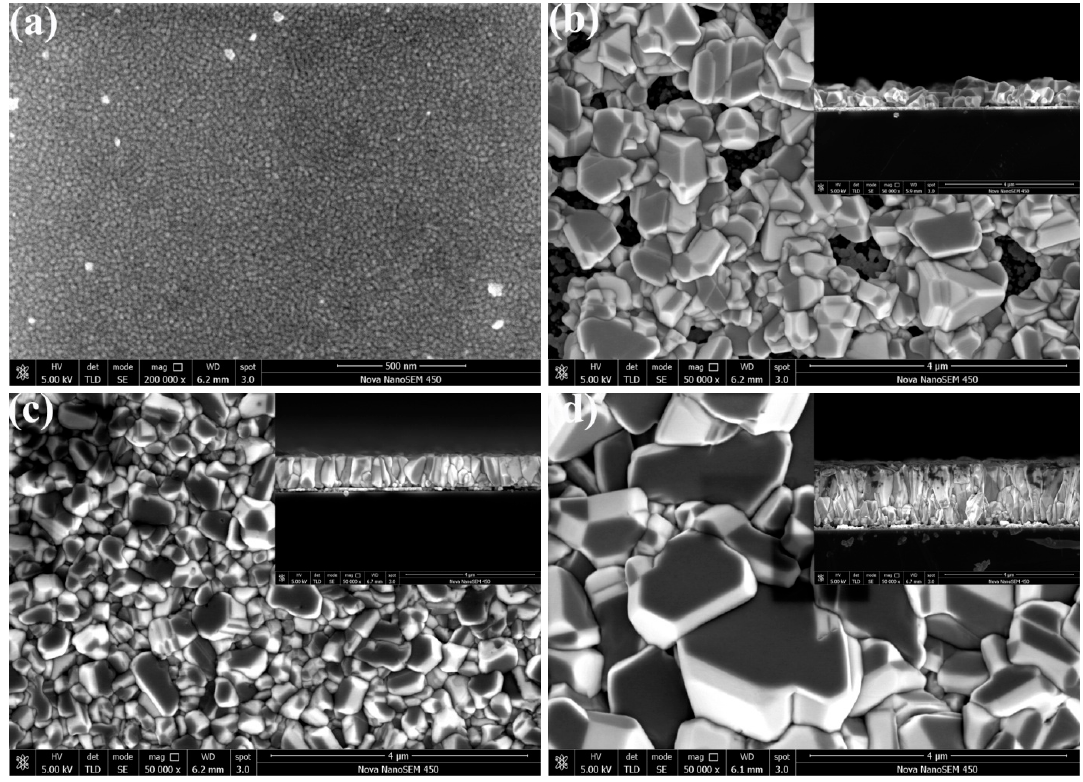
Figure 1. ( a ) Surface SEM images of the Cu films. Surface and cross-sectional (inset) view SEM images of the CuI thin films grown with different thickness of Cu films ( b ) 80 nm; ( c ) 200 nm; ( d ) 500 nm.